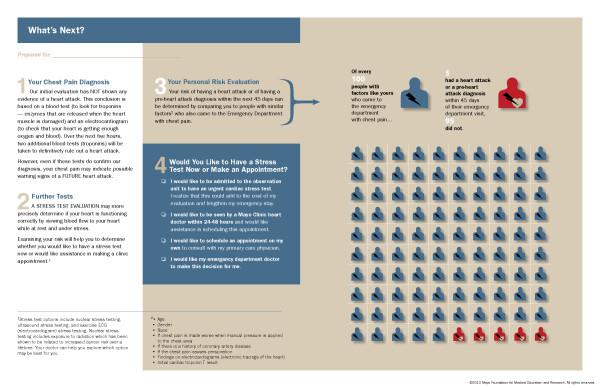
Chest Pain Choice Decision Aid.